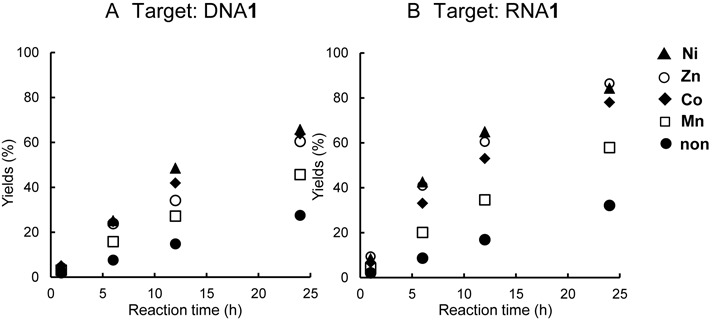
Effect of metal cations on the crosslinking reaction rate. The reactions were performed under the same conditions as described in Figure 2 with 1 mM NiCl2, ZnCl2, CoCl2 and MnCl2. After the incubation for the indicated time, each mixture was analyzed by denaturing gel electrophoresis.